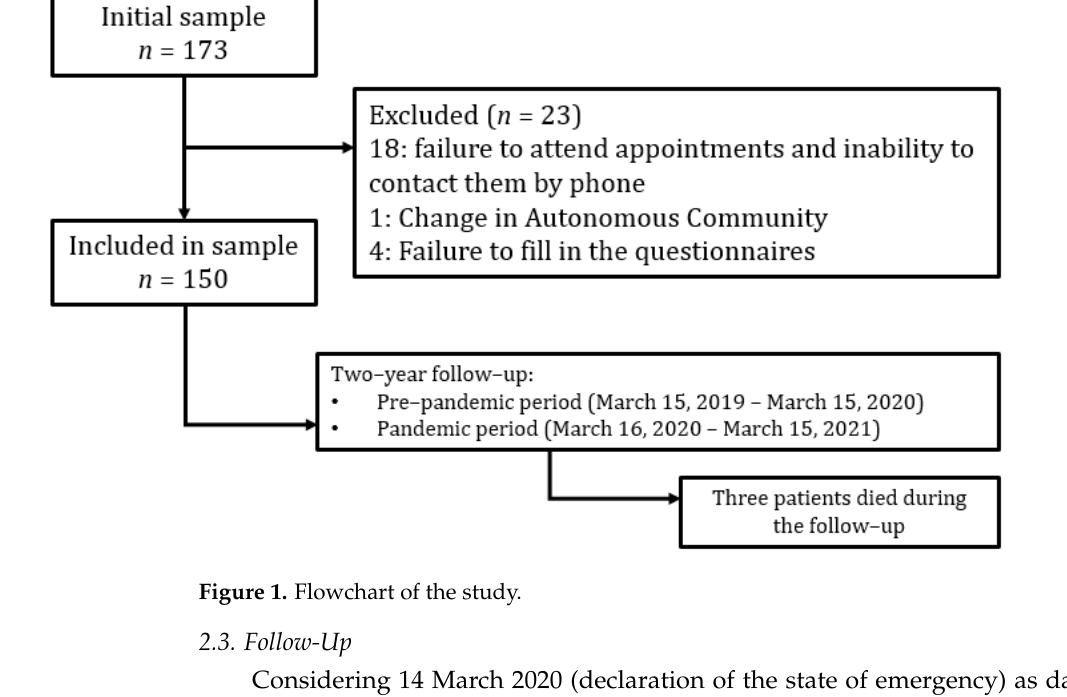
Figure 1. Flowchart of the study.